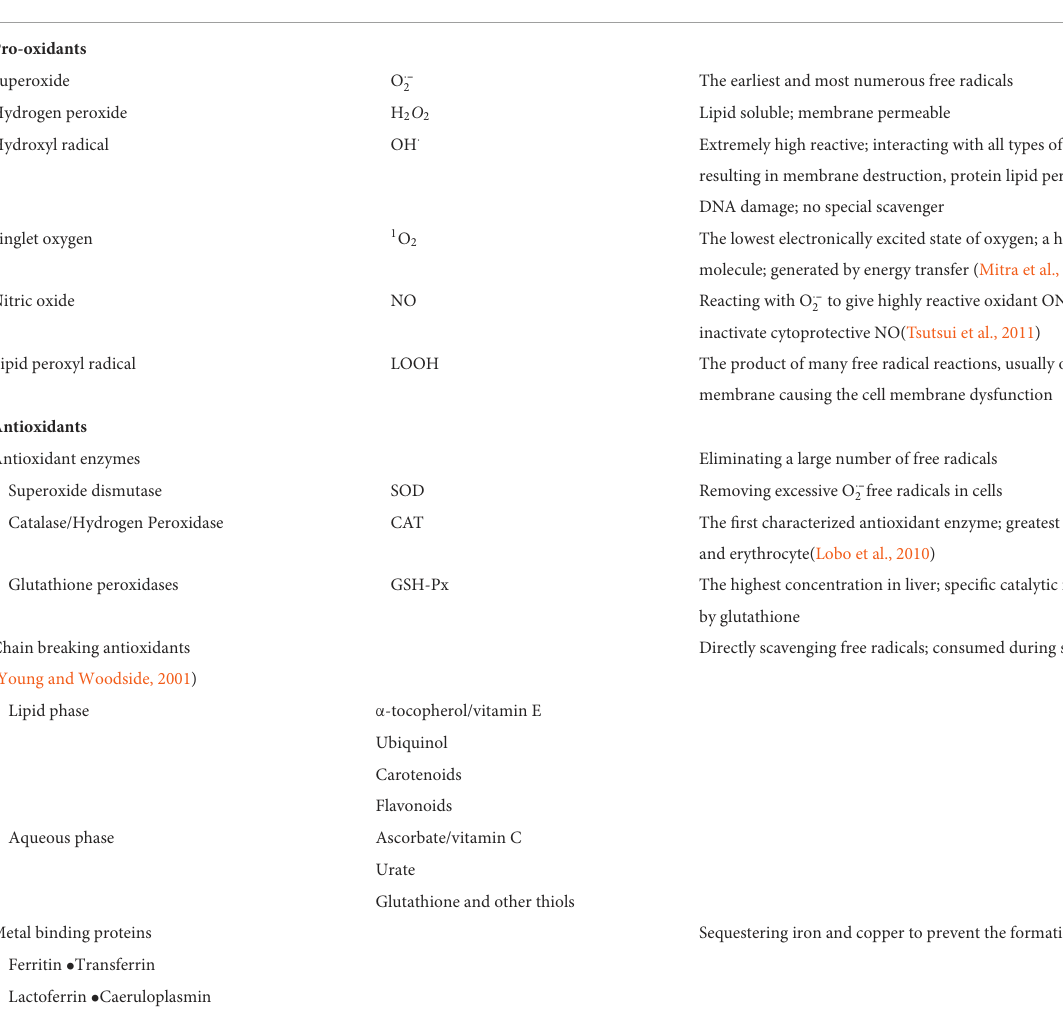
TABLE 1 ROS and the antioxidant defense